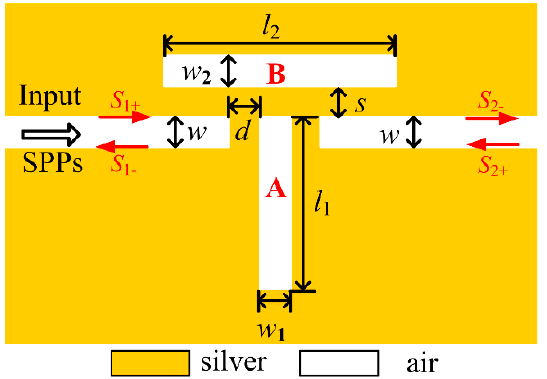
Figure 1. Schematic diagram of the Fano resonant MIM structure, the metal and insulator are silver and air, respectively.